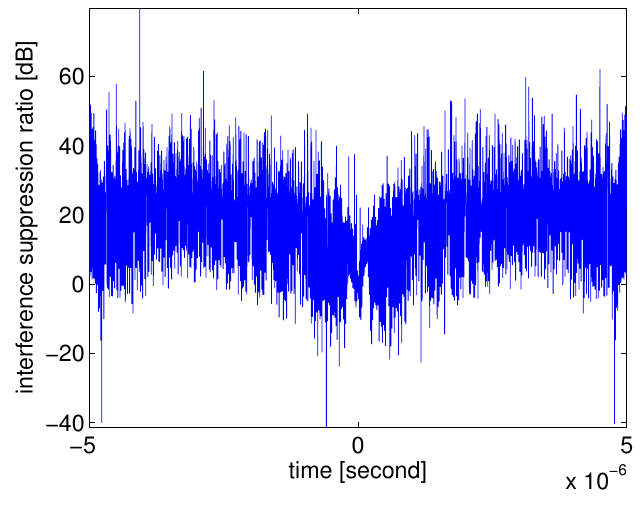
Figure 5. Result of the interference suppression ratio.